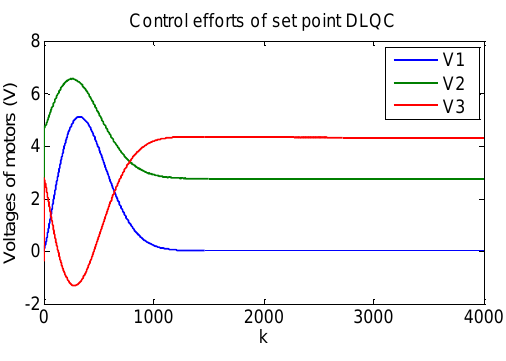
Figure 11. Control efforts of